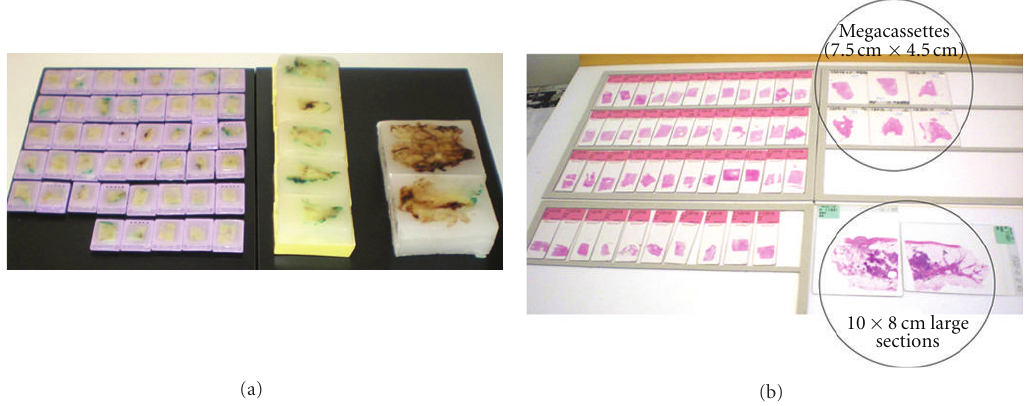
Figure 1: Comparison of the relative number of para ffi n blocks (a) and glass slides (b) needed to cover an equivalent area from the same surgical specimen: 45 small, conventional para ffi n blocks/slides, five megacassettes/megaslides (7 . 5 × 4 . 5cm), and two 10 × 8cm para ffi n